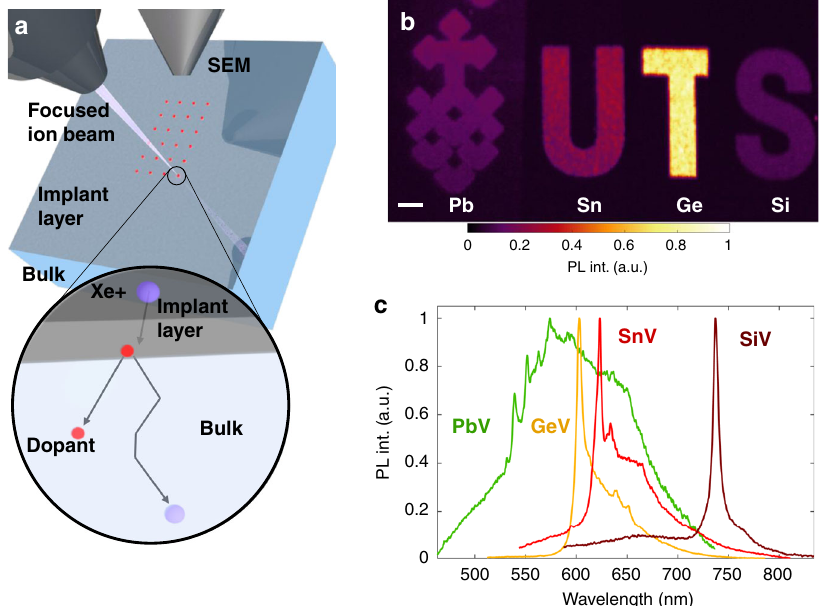
Fig. 1 Creation of colour centres in a diamond target by recoil-implantation. a Schematic illustration of the process inside a standard electron-ion dual beam microscope. The inset shows an atomic picture of the process: momentum is transferred from inert primary ions to the atoms of a thin fi lm comprised of the dopant material, resulting in implantation of the latter into the underlying target. b Photoluminescence map of a pattern fabricated in a single region of diamond using four dopant species that were implanted by momentum transfer from an electrostatically scanned Xe + beam. The emblem is patterned in Pb, and the letters U, T, and S in Sn, Ge, and Si, respectively. The scale Bar corresponds to 5 μ m. c Photoluminescence spectra recorded from the implants in b , showing characteristic emissions from defect complexes that contain the Pb (green), Ge (orange), Sn (red), and Si (maroon)